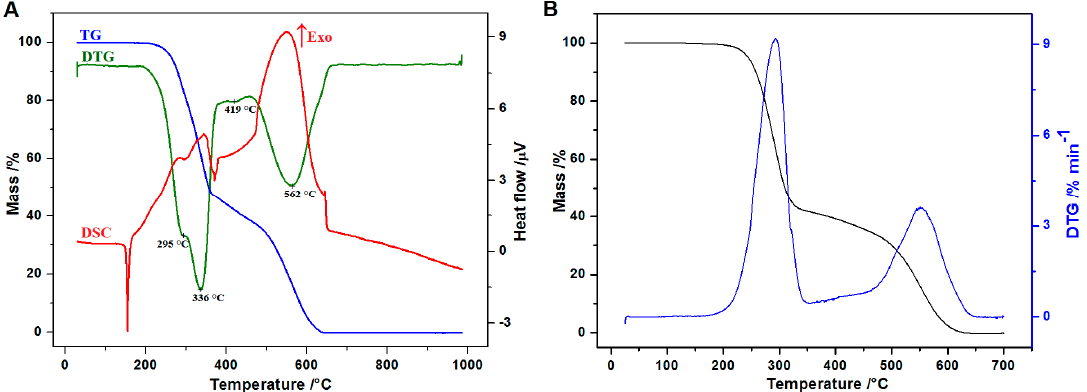
Figure 8. ( A ) TG, DTG and DSC curves of the studied compound recorded in air atmosphere using cylindrical shape crucible; ( B ) TG and DTG curves of the studied compound recorded in air atmosphere using used flat platinum plate (heating rate 10 °C min − 1 ).